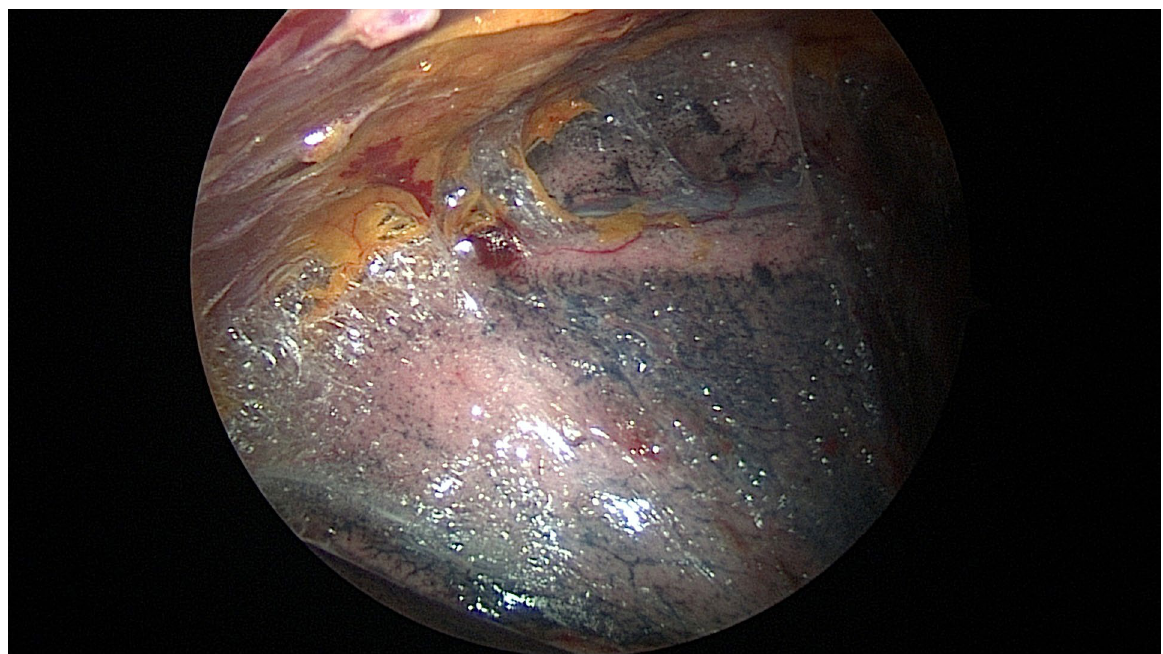
Figure 4. Intraoperative photograph of the flimsy pleural adhesions after simultaneous Viscum pleurodesis and